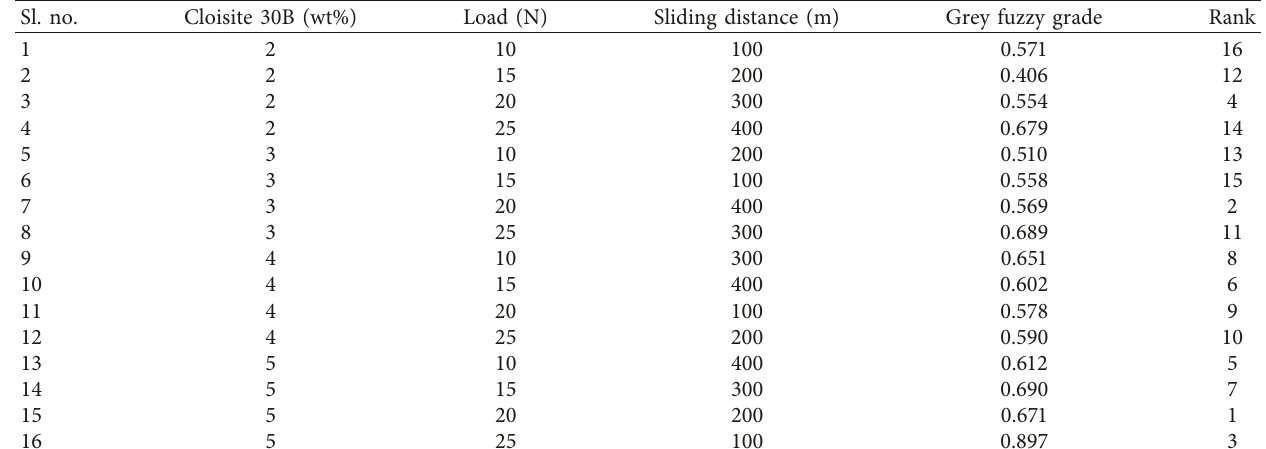
Table 5: The abrasive wear responses at grey fuzzy reasoning grade.